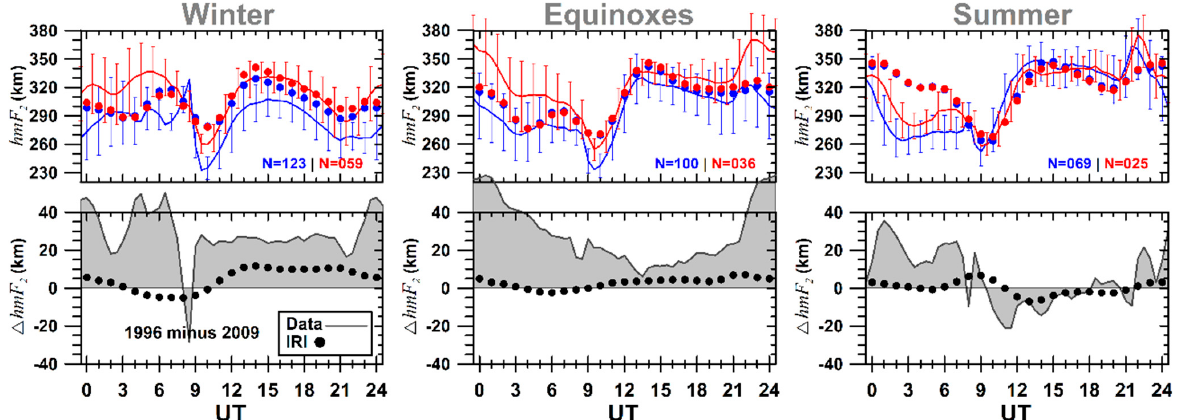
Figure 3 . The universal time and seasonal variations of the hmF 2 parameter over São Luís for 1996 (red) and 2009 (blue). The dots represent the IRI estimations (one-hour step), while the continuous lines are the 30 min averaged data by season (the error bars represent a 1 SD confidence interval for each 60-min). The N denotes the number of available days used for the average computation. The lower panels show the differences between 1996 and 2009 for the data (the gray area) and model (back points) for both periods (see text for more details). The local time (LT) for São Luis is related to the universal time as LT = UT − 3 h.